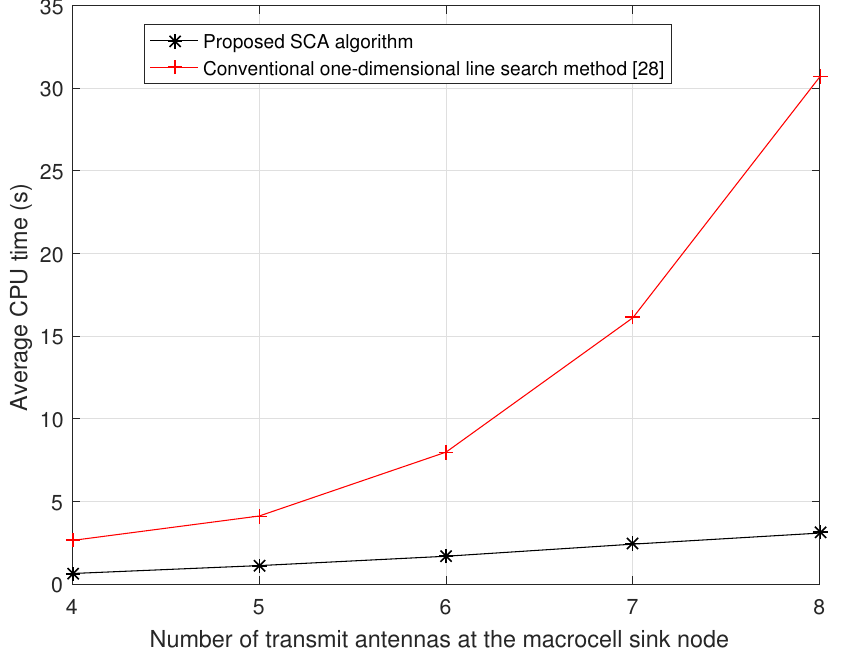
Figure 7. Average CPU time with respect to the number of transmit antennas at the macrocell sink